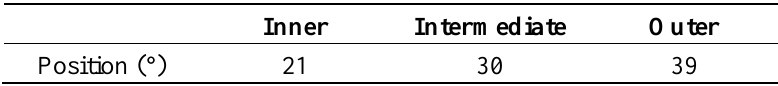
Table 9. Case 1 motion state of the turntable.